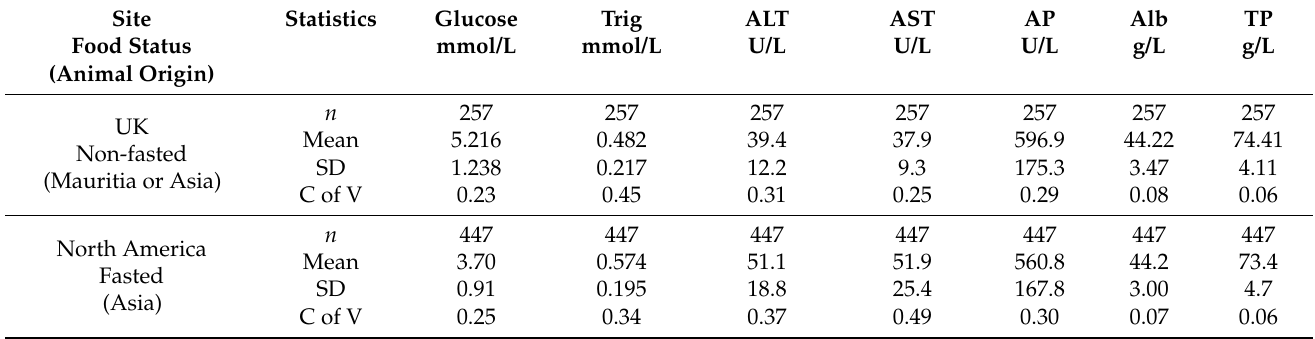
Table 3. Summary of clinical pathology data from male Cynomolgus Macaques (aged under 60 months).